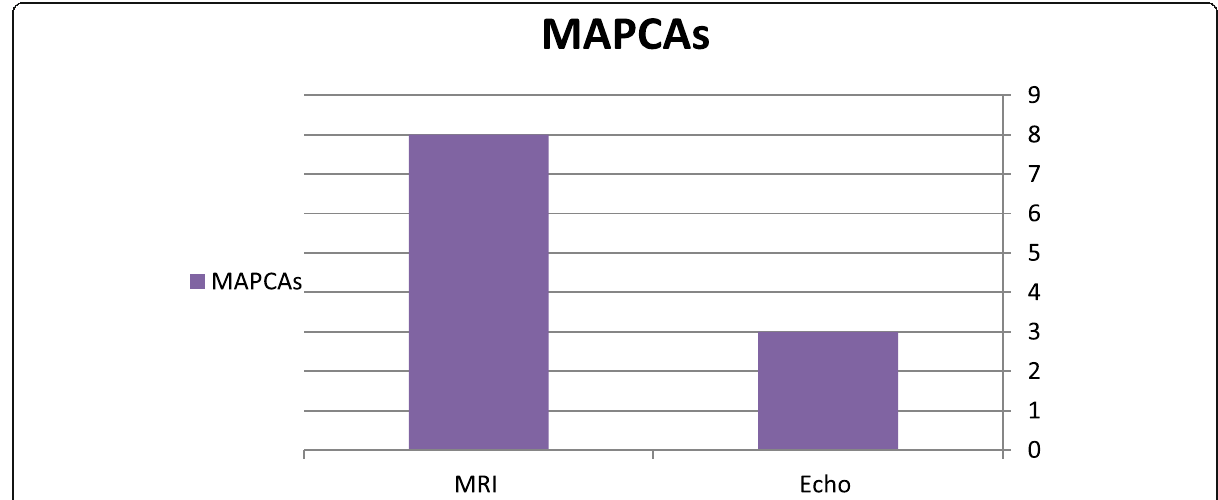
Fig. 4 Number of cases of aorto-pulmonary connection by echocardiography and MRI. *MAPCAs: Major aorto-pulmonary collateral arteries